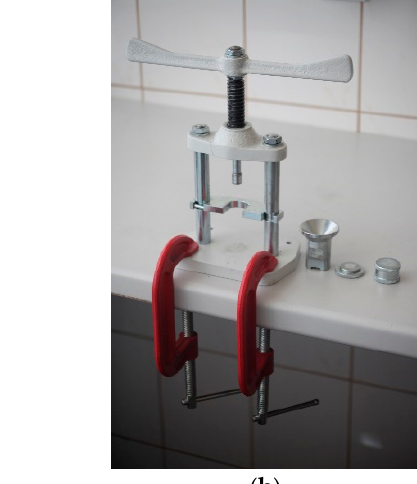
Figure 9. Example time–temperature curve from EN ISO 18125:2017-07 [18]. The exact value of the heat of combustion was determined using the Formula (1) [18], where 𝑞 (cid:3049),(cid:3034)(cid:3045) is the gross calorific value at constant volume of the fuel as analyzed, in J·g − 1 ; 𝜀 (cid:4666)(cid:3041)(cid:4667) —is the mean value of the effective heat capacity of the calorimeter as determined in the calibrations, in J·K; 𝜃 —is the corrected temperature rise, in K; 𝑄 (cid:3033)(cid:3048)(cid:3046)(cid:3032) —is the contribu- tion from the combustion of the fuse, in J; 𝑄 (cid:3036)(cid:3034)(cid:3041) —is the contribution from the oxidation of